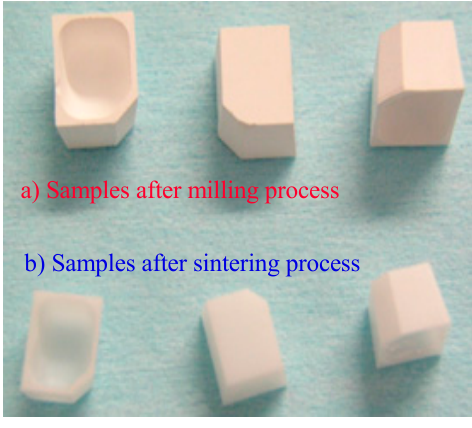
Figure 3. The samples.